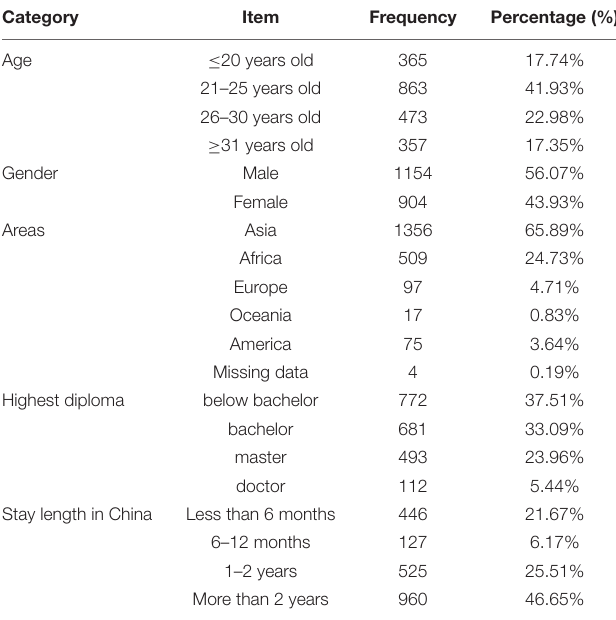
TABLE 1 | Demographic statistics of the sample ( N =